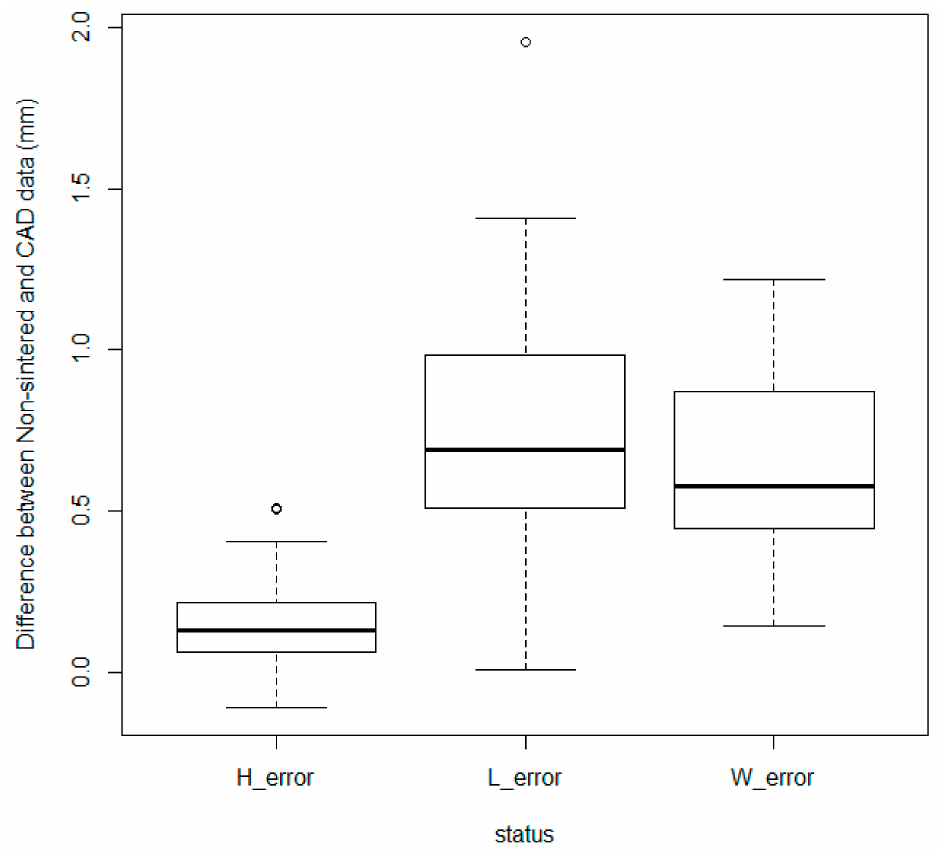
Figure 5. Difference between non-sintered and CAD